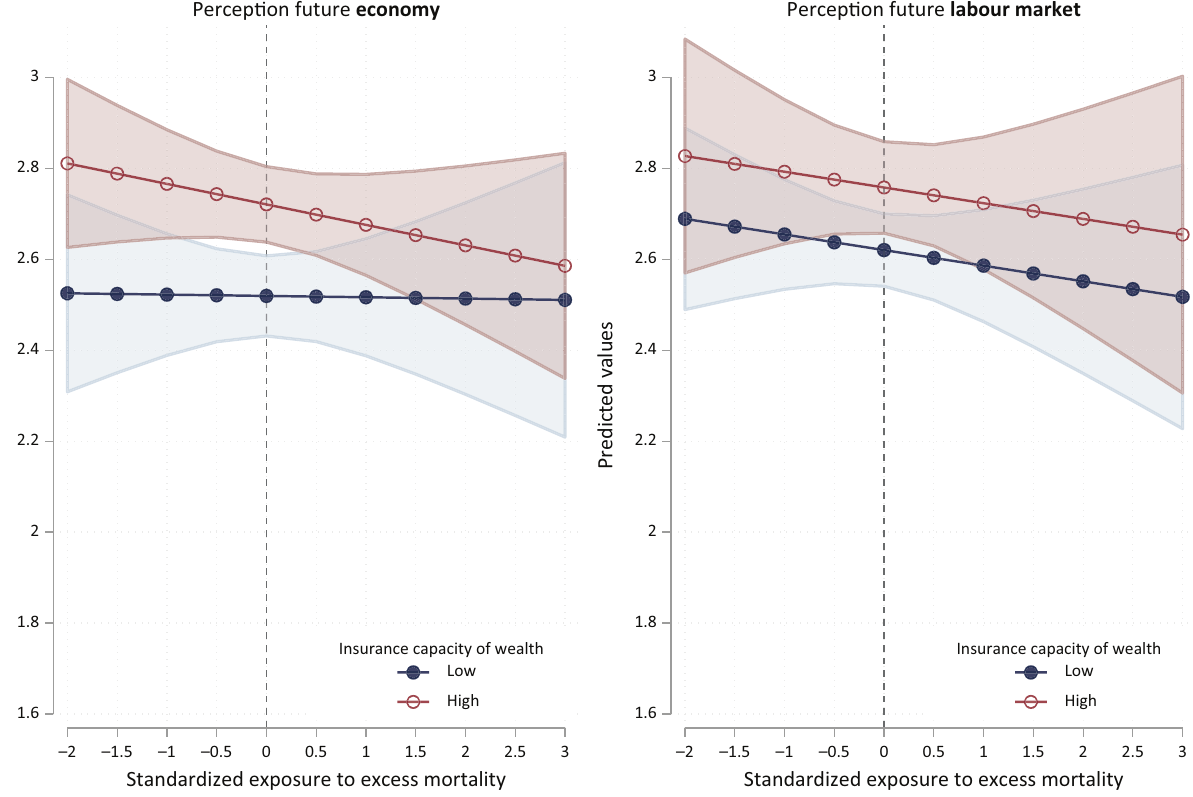
Figure 4. Predicted levels of dispositional optimism from linear mixed models for individuals with very poor and excellent insurance capacity of wealth, conditional on exposure to excess mortality (N = 11,350). Note: See Section 3.2 for details about the operationalisation of the insurance capacity of wealth. Source: Authors’ work based on Bank of Italy (2022); Istat (2022).